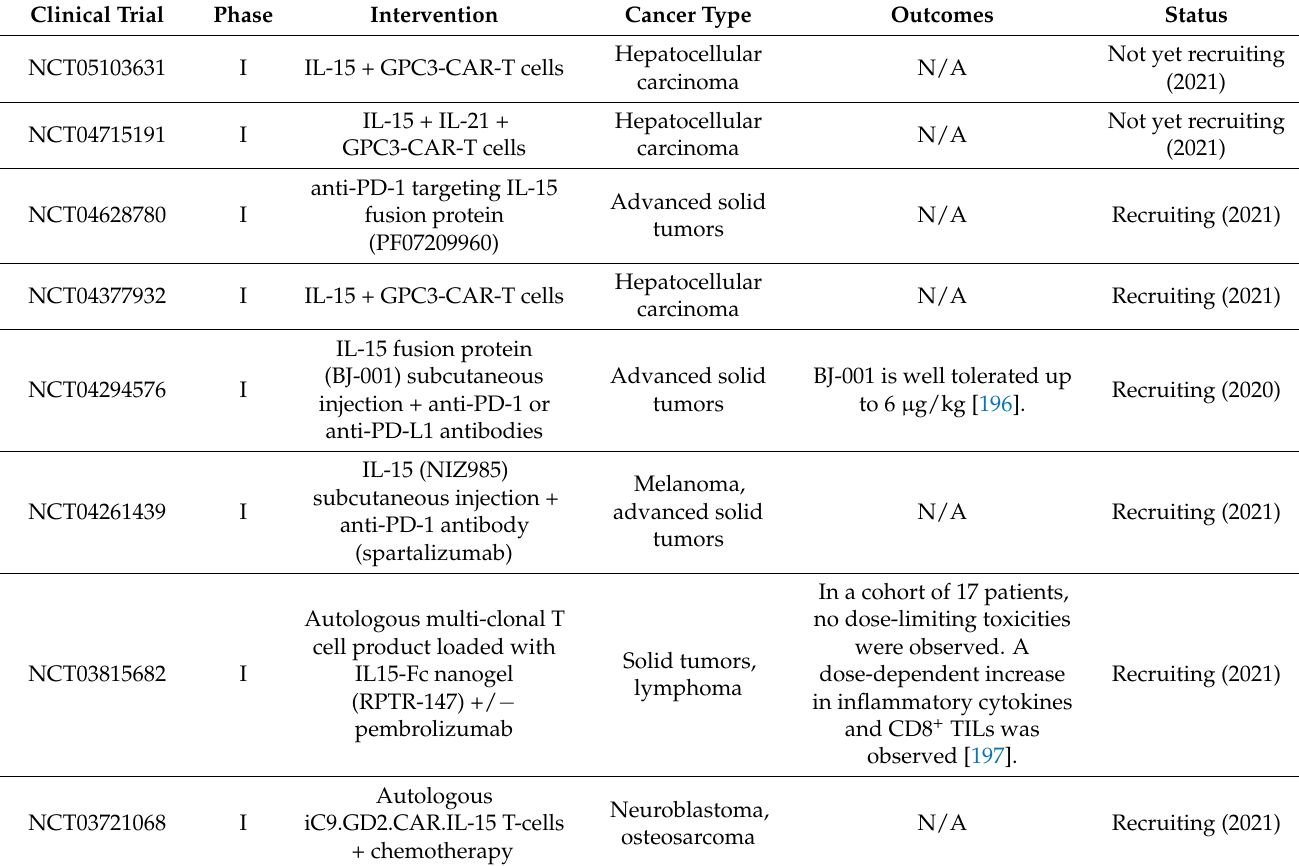
Table 3. Clinical trials targeting IL-7, IL-12, IL-15, and IL-21 cytokine signaling in